Question: Describe this figure in one sentence.
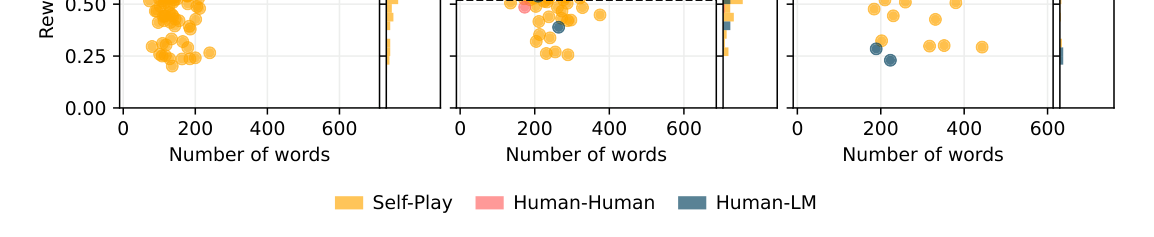
Answer: Human-LM and self-play scores compared to human dialogues, plotted against dialogue lengths in words. LM assistants achieve lower scores than human assistants on average, and also tend to have longer dialogues. Models in self-play have even lower scores and longer dialogues since they must also play the role of a cooperative user. The histograms show the marginal distributions of the scores and dialogue lengths. The dashed line shows the average score of a random proposal.